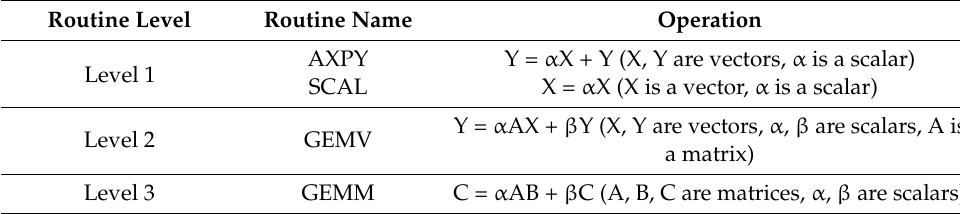
Table 2. List of representative BLAS routines provided by our